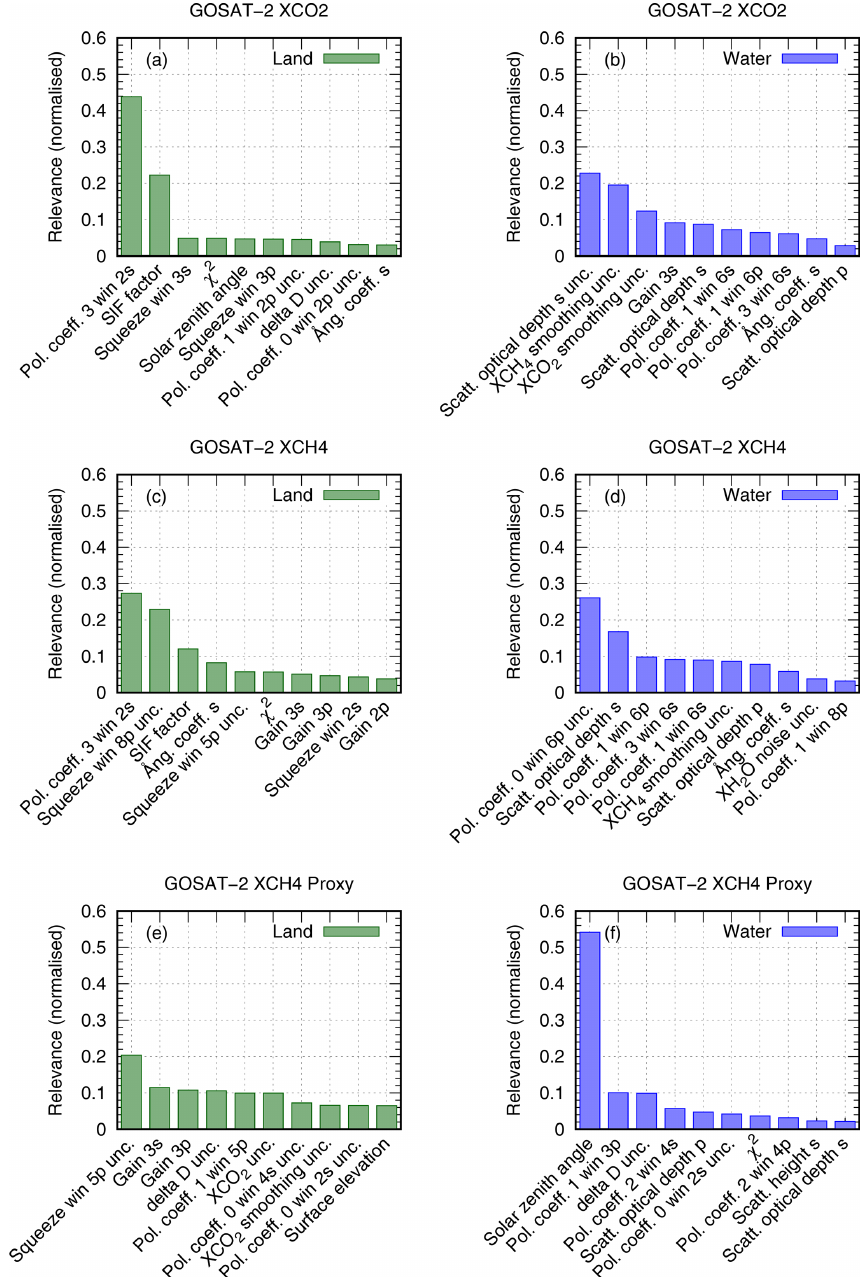
Figure A8. Same as Fig. A7 but for